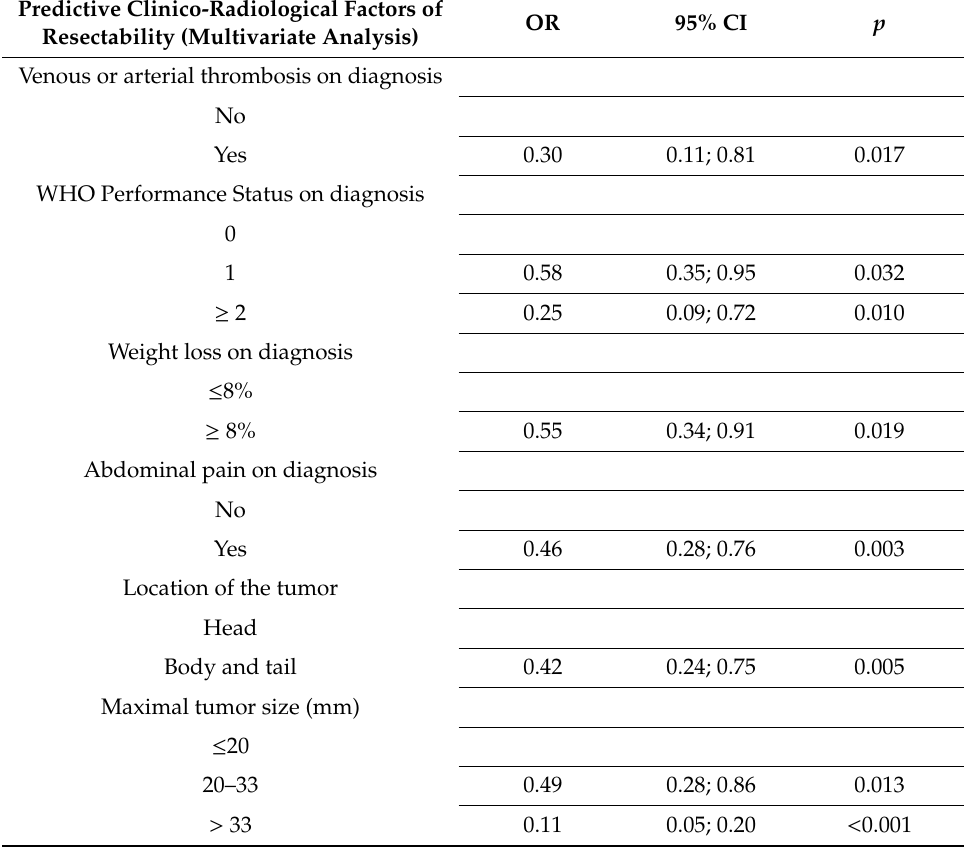
Table 2. Predictive clinico-radiological factors of resectability (multivariate analysis). Predictive Clinico-Radiological Factors